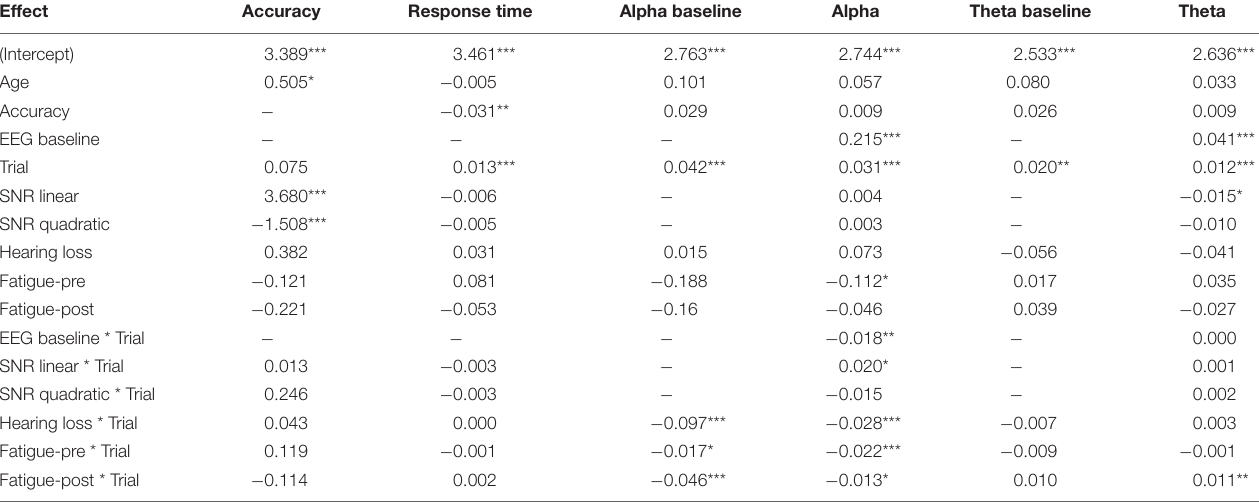
TABLE 1 | Model results for each dependent